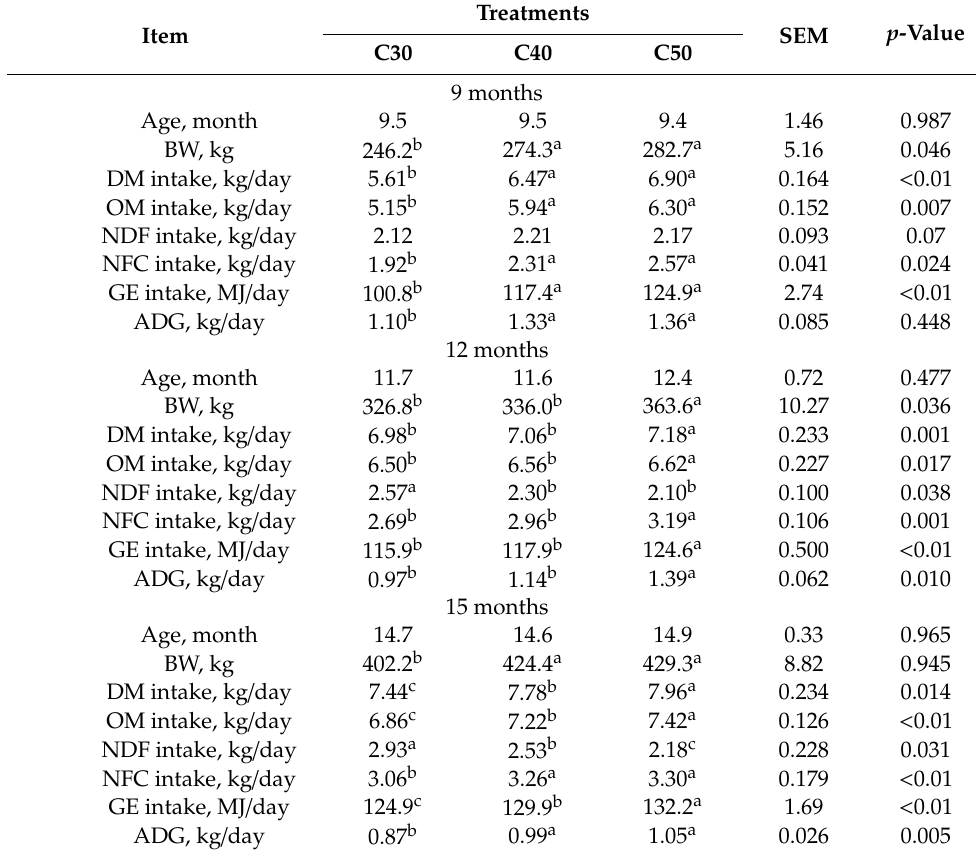
Table 2. E ff ects of di ff erent dietary concentrate levels on the growth performance of Holstein heifers at age of 9, 12 and 15